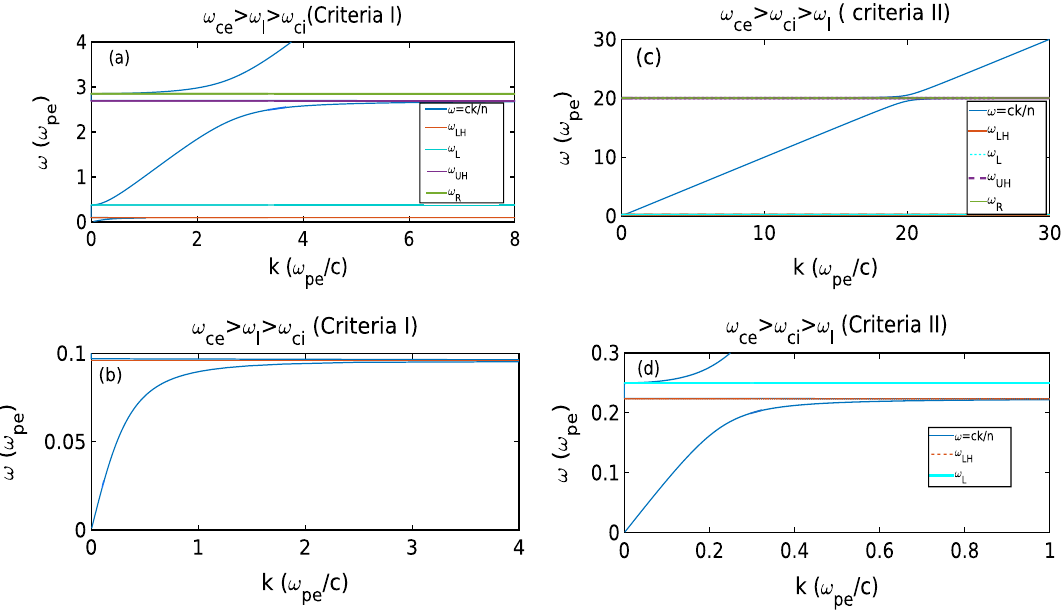
Figure 3. Dispersion curve for two criteria [criteria I (ω ce > ω l > ω ci ) and criteria II ( ω ce > ω ci > ω l ) are shown in subplot ( a ) and ( c ) respectively]. In subplot ( b ) and ( d ), we expand the dispersion curves shown in ( a ) and ( c ) respectively. From these curves, we can observe that while criteria I has two stop bands and three pass bands, criteria II dispersion has ω = ck all along. Criteria